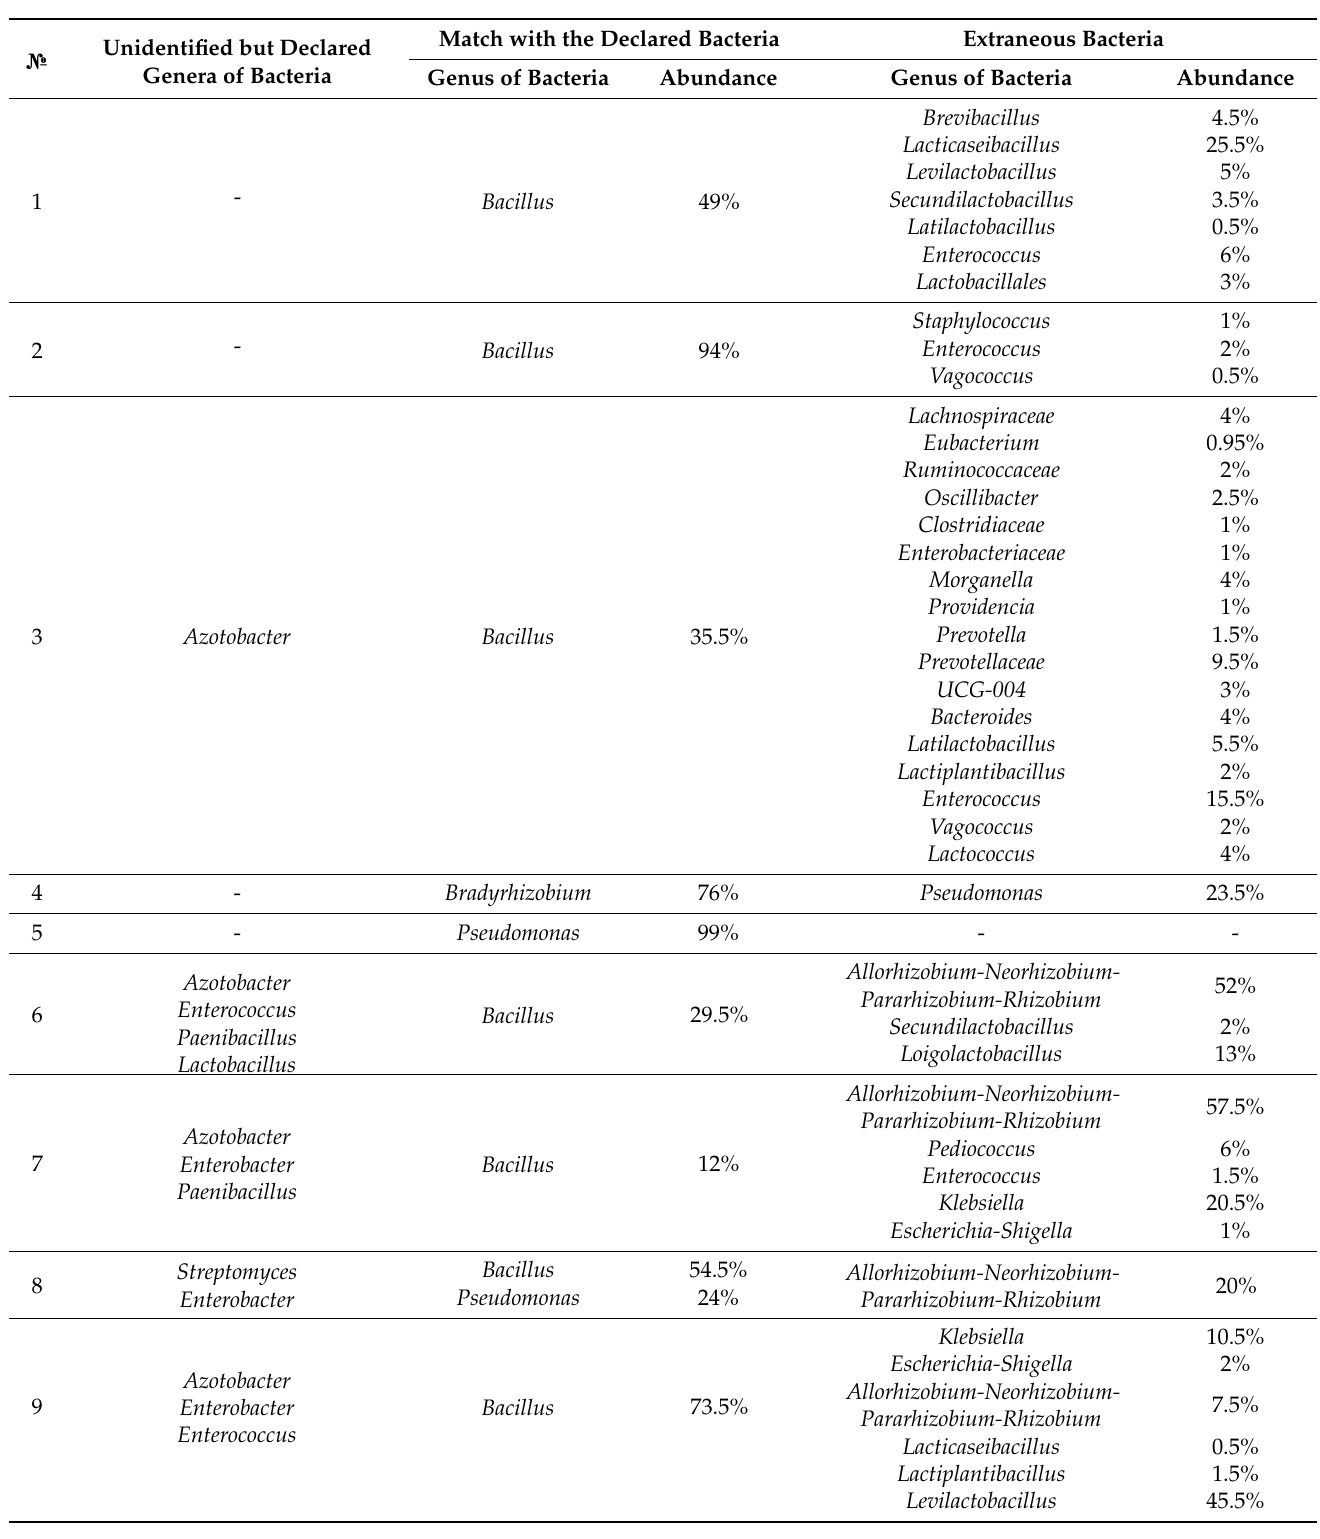
Table 2. Comparison of the declared bacterial taxa with the identified